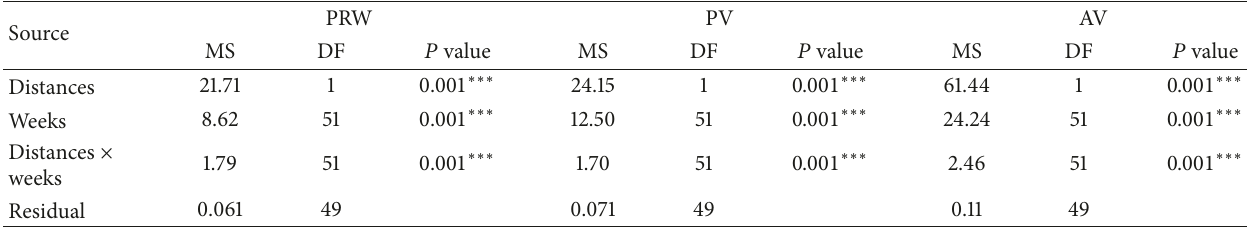
Table3:ANOVAascosporesonVaseline(AV),pycnidiosporesonVaseline(PV),andpycnidiosporesonrainwater(PRW)sampledatdifferent distances and weeks during the second period (1999-2000).